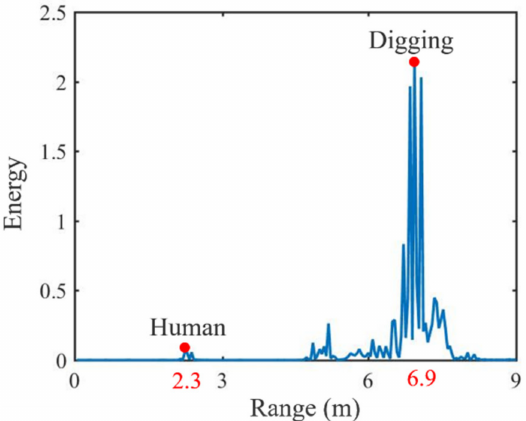
Figure 10. Traditional method used to detect targets by identifying the maximum energy